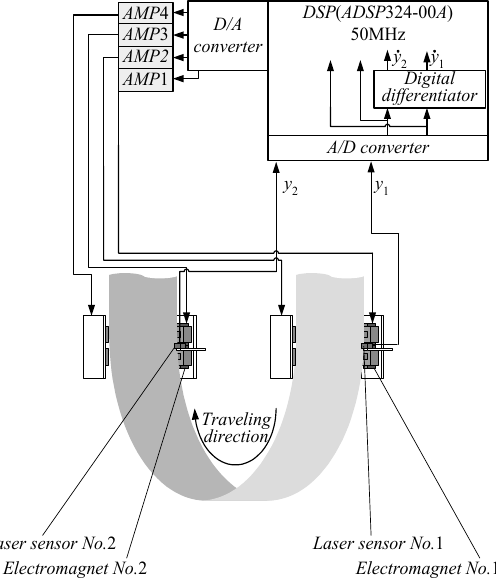
Figure 4. Control system of noncontact guide.